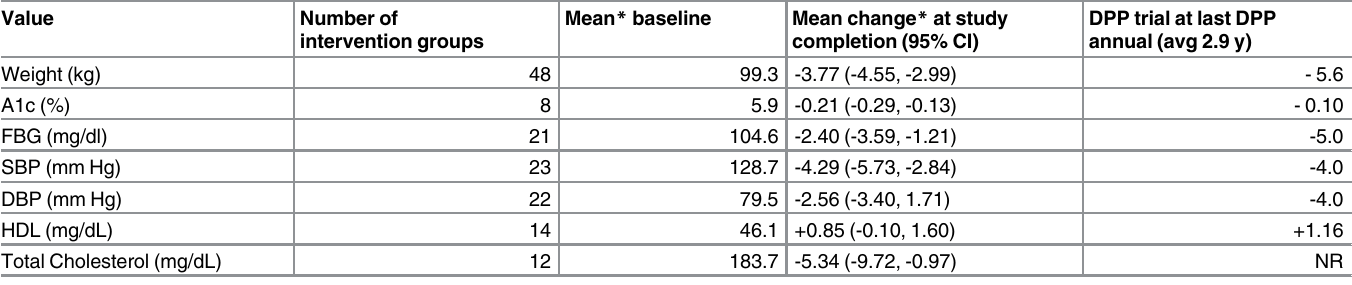
Table 2. Comparison of outcomes from DPP versus Community